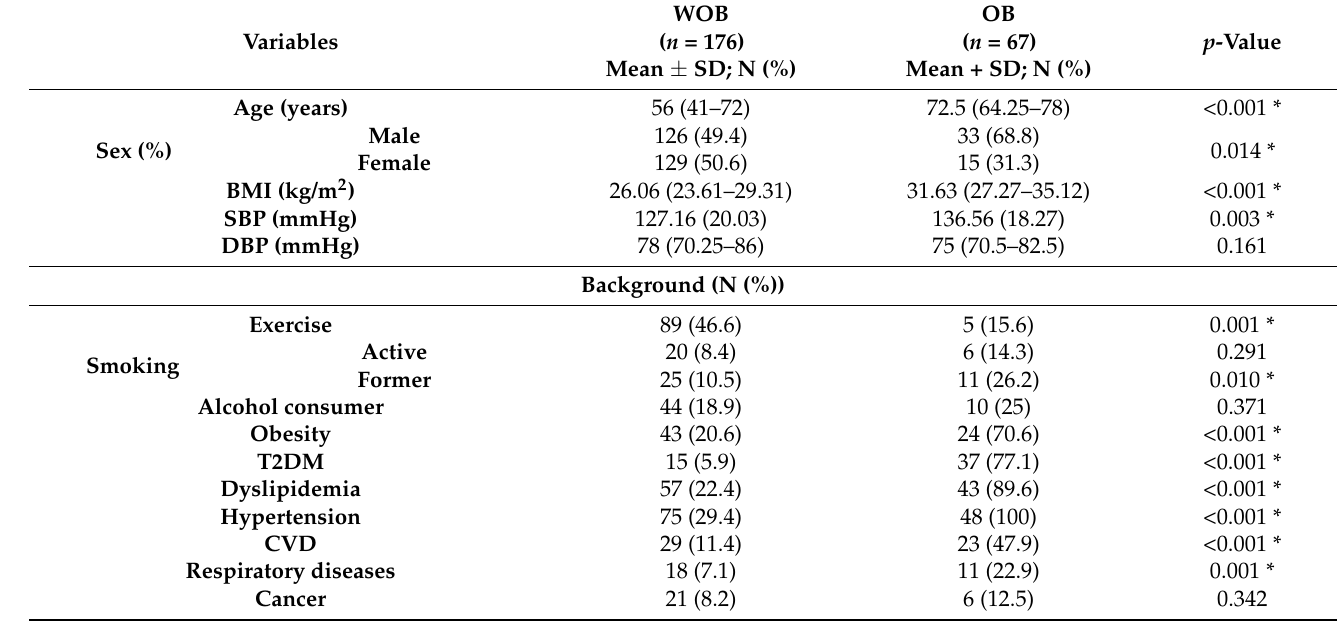
Table 2. Background, comorbidities, COVID-19 treatment, and anthropometric, clinical, and biochemical variables of the COVID-19 cohort classified according to the BMI (<30 and ≥ 30 kg/m 2